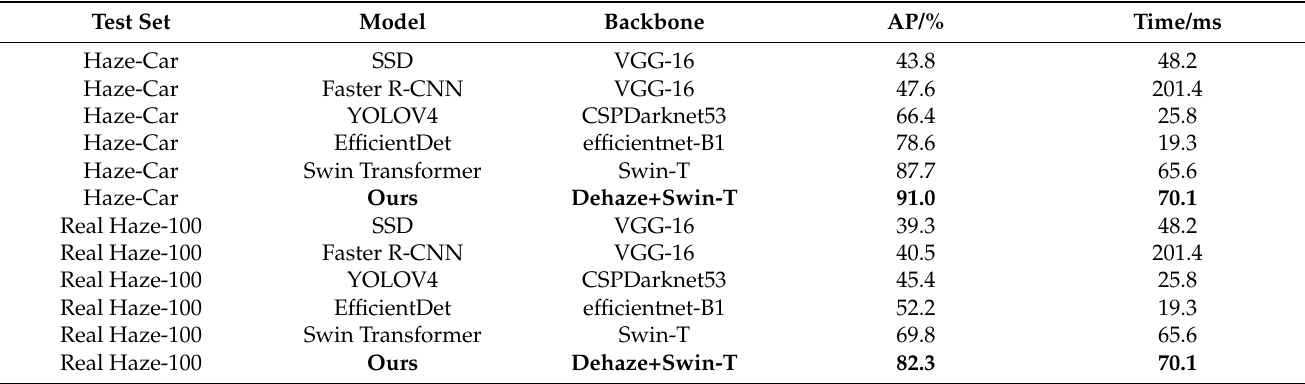
Table 3. Comparison results of different detection algorithm